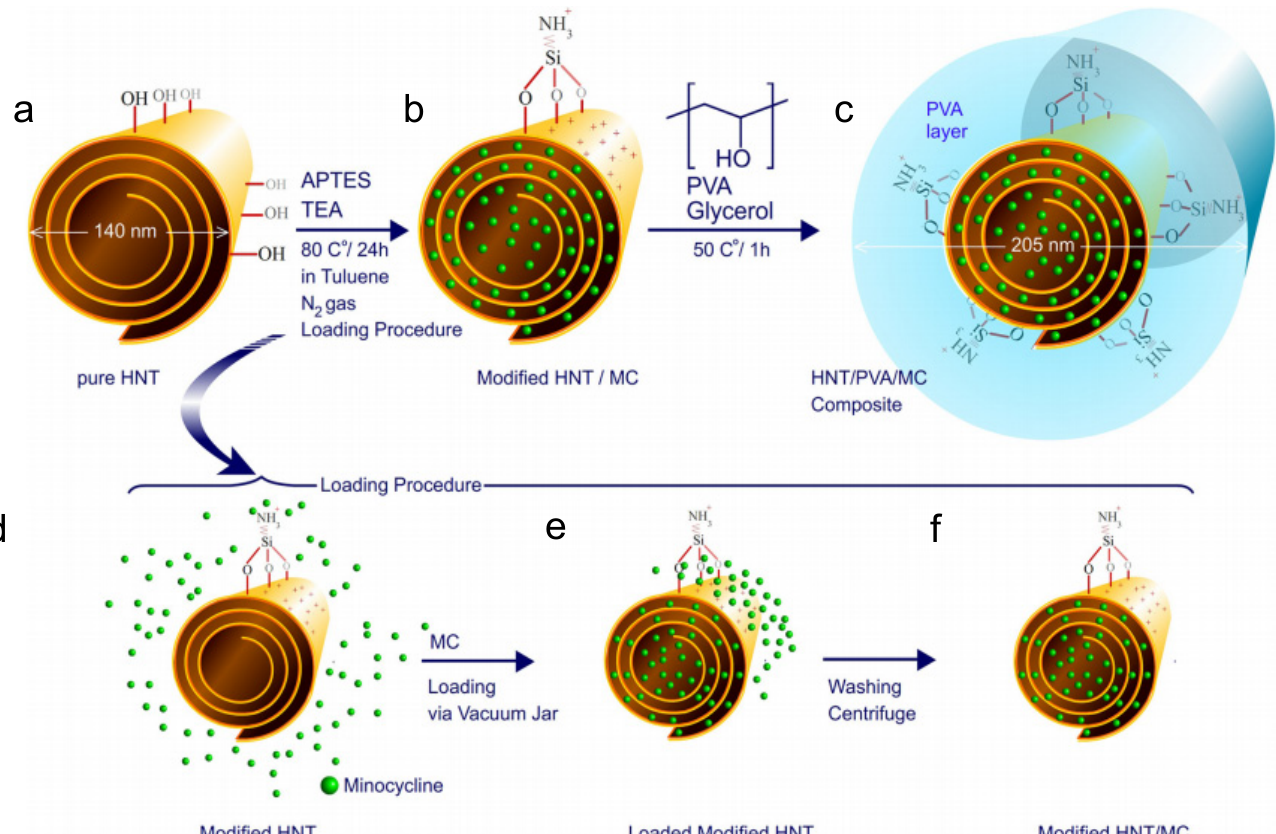
Figure 4. SEM image of pure HNT ( a ), surface of HNT/PVA ( b ), cross section of HNT/PVA ( c ), sur- face of HNT/PVA/MC, Schematic of drug loading, surface modification, and synthesis of HNT/PVA nanocomposites ( d – f ). Reprinted by permission of the publisher.